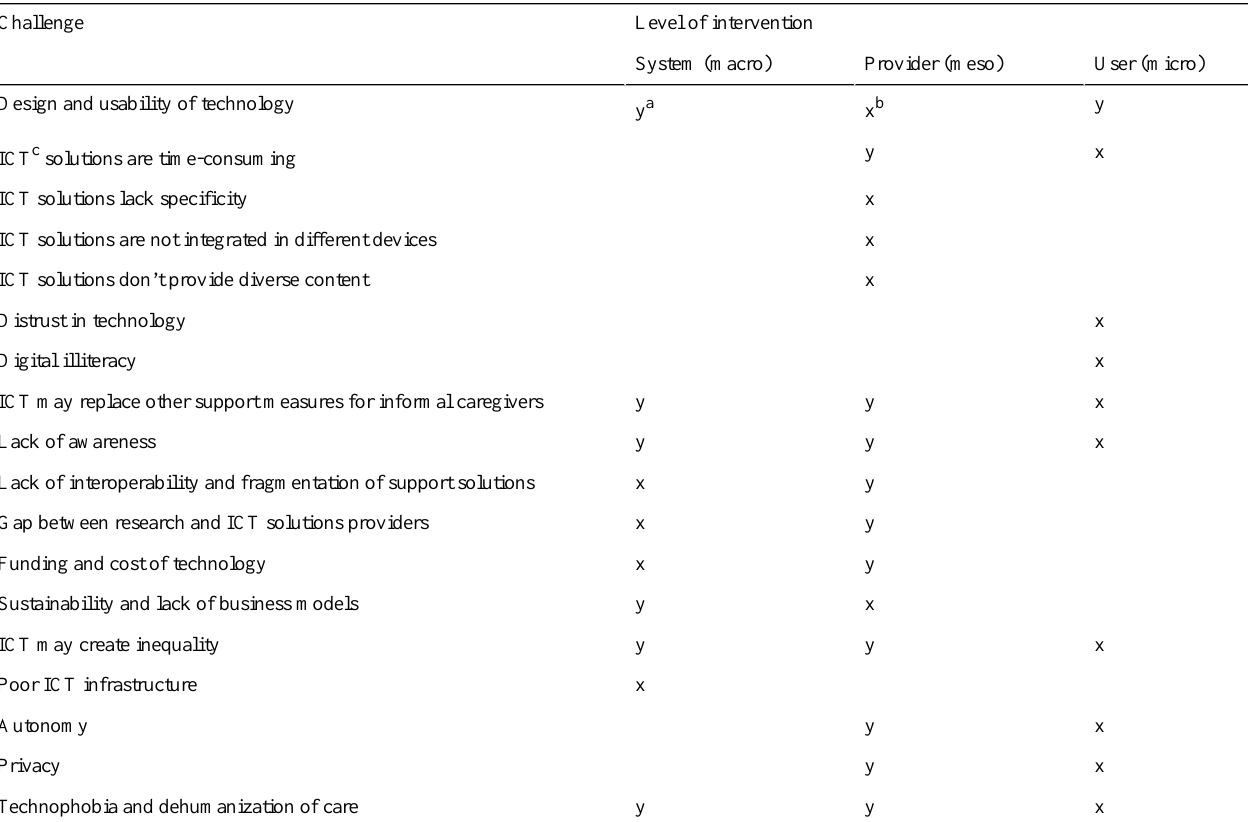
Table 5. Overview of the prevailing and possible additional levels of interventions recommended to address the identified